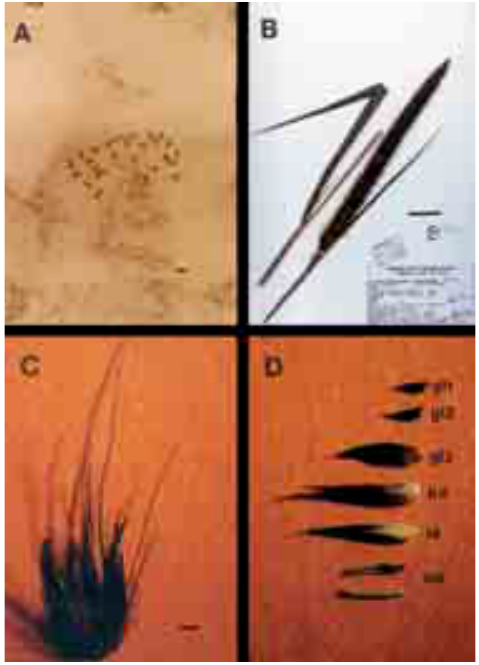
Figure 1 - BAG 65 ( P. purpureum ). A. Mitotic metaphase with 2n = 28 chromosomes; B. Specimens; C. Spikelet; D. Constituent of the spikelet: an (anthers), le (lemma), pa (palea), gl3 (3 rd glume), gl2 (2 nd glume), gl1 (1 st glume). The bars represent: A. 5 µ m; B. 5.6 cm; C and D. 2.3 mm. UFLA. Lavras, MG, Brazil, 1998.